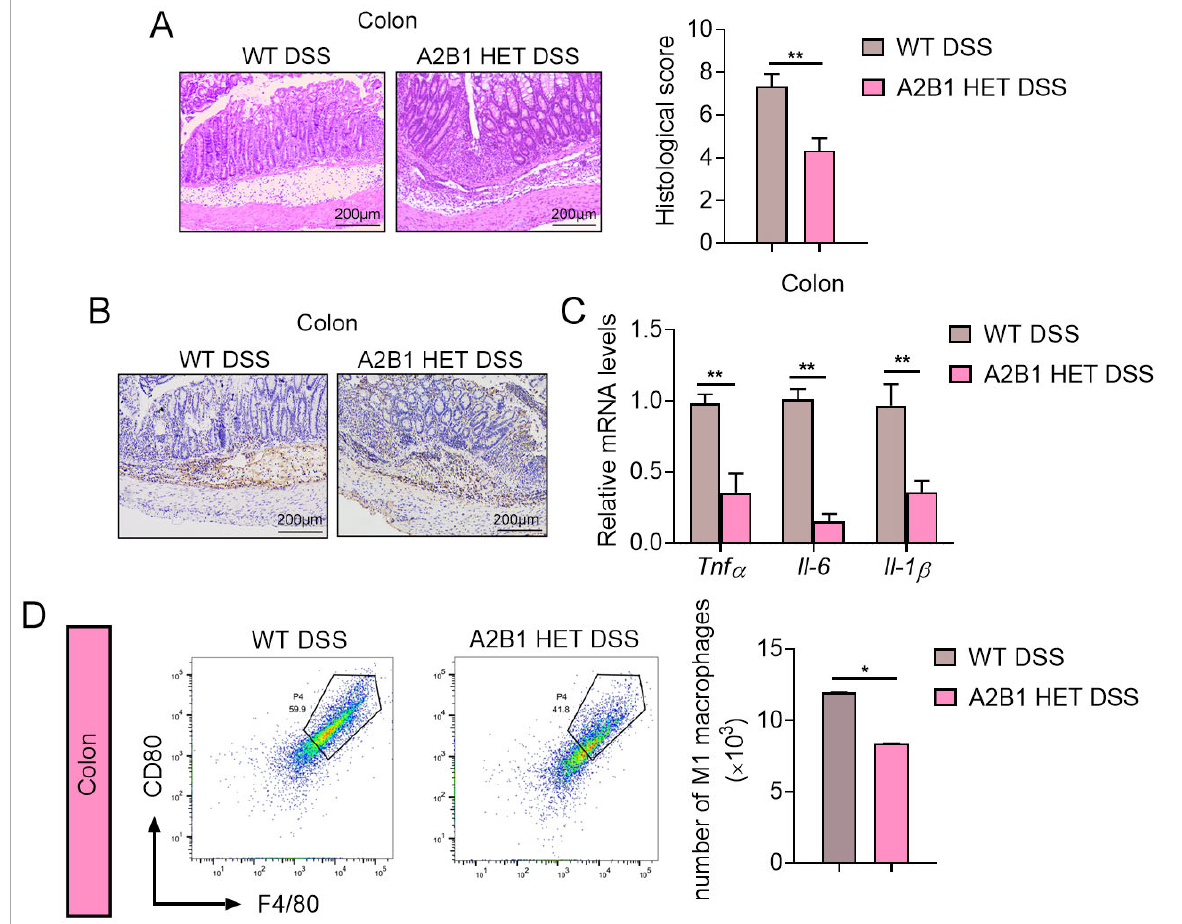
Figure 3. hnRNPA2B1 reduction attenuated colitis and inflammatory signs in DSS-induced IBD mice. ( A ) Colonic tissue H&E staining for the assessment of histological changes. ( B ) Immunohisto- chemistry analysis of F4/80 levels of colon tissues. ( C ) Relative proin fl ammatory genes mRNA levels in colon tissues of WT and A2B1 HET mice treated with DSS. ( D ) Flow cytometry and numbers of CD45+F4/80+CD80+ macrophages in colon of WT and A2B1 HET mice treated with DSS. Results are shown as mean ± SEM; * p < 0.05, ** p < 0.01.